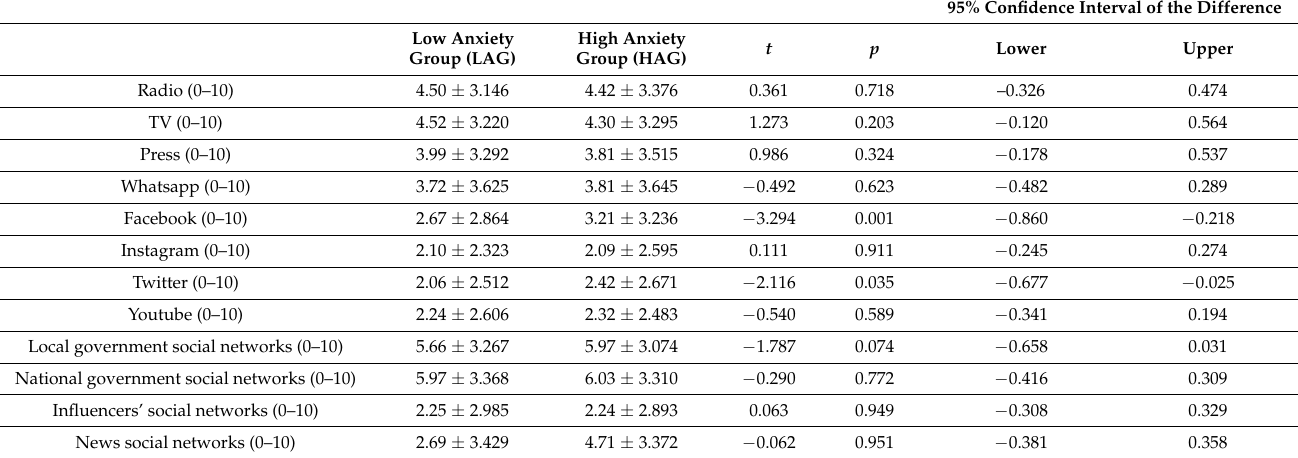
Table 3. Use of social networks between groups.